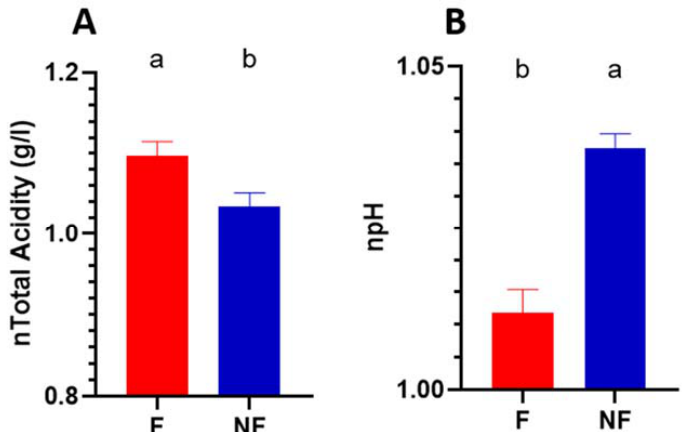
Figure 7. Normalized values of total acidity ( A ) and pH ( B ) recorded at harvest. Values represent the mean ± SE for F ( n = 50) and NF ( n = 70). Values were normalized on the average of 2018–2019. Different letters indicate significant differences among treatments according to Student’s t ‐ test ( p ≤ 0.05).